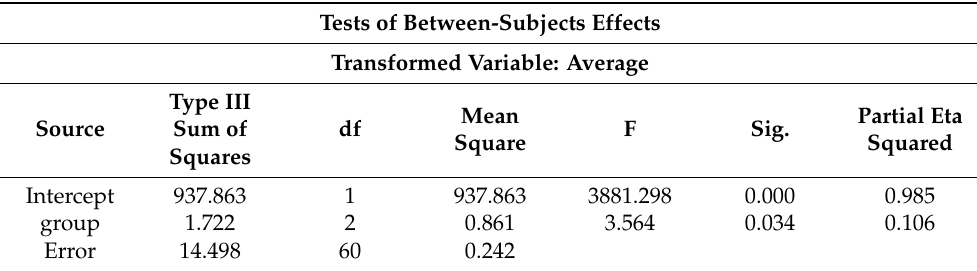
Table 4. Results of mixed ANOVA to test the between-subjects effects of group factor (ASD, ADHD, and control) for MSE values (dependent